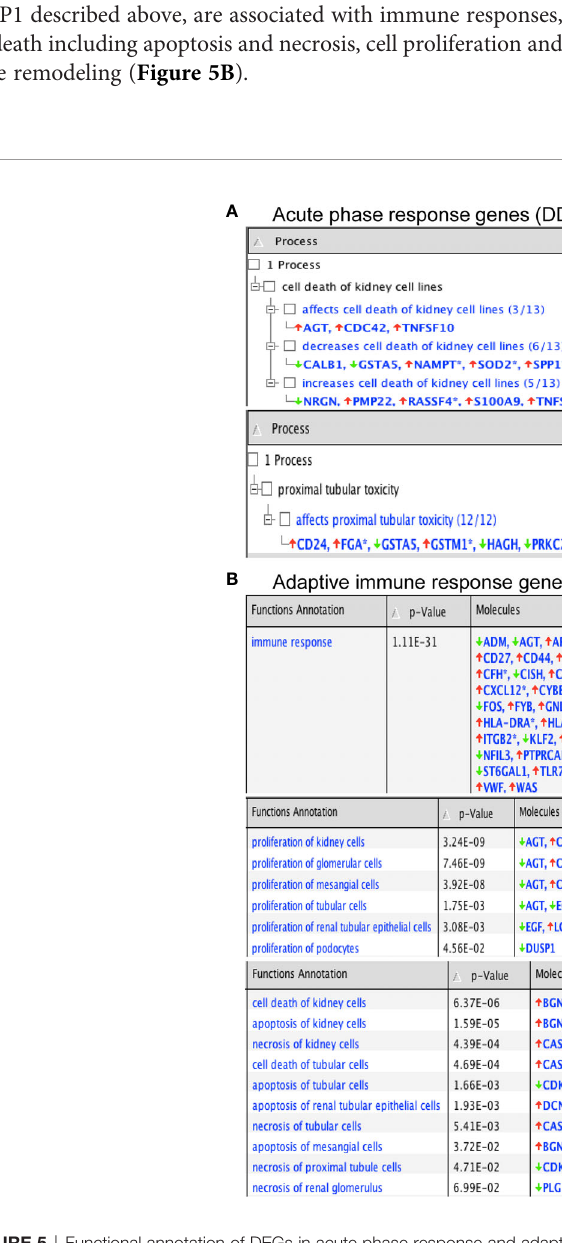
FIGURE 5 | Functional annotation of DEGs in acute phase response and adaptive immunity by Ingenuity Pathway Analysis. (A, B) P-values were calculated using a Right-Tailed Fisher ’ s Exact Test to re fl ect the association between DEGs and a given